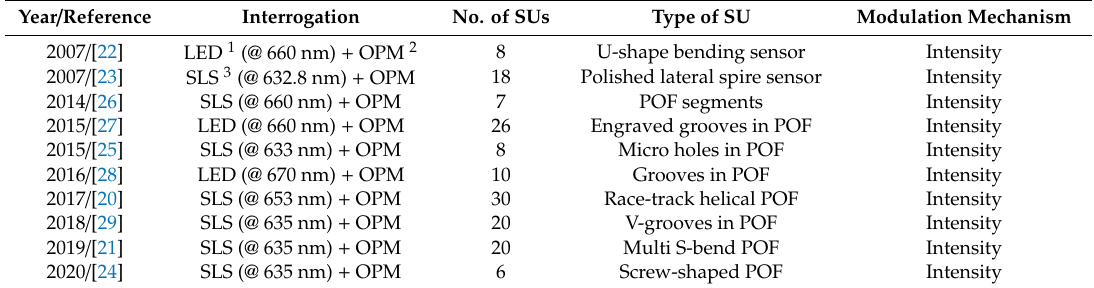
Table 1. Examples of discrete optical fiber sensor networks based on various specialty fibers for water level monitoring.